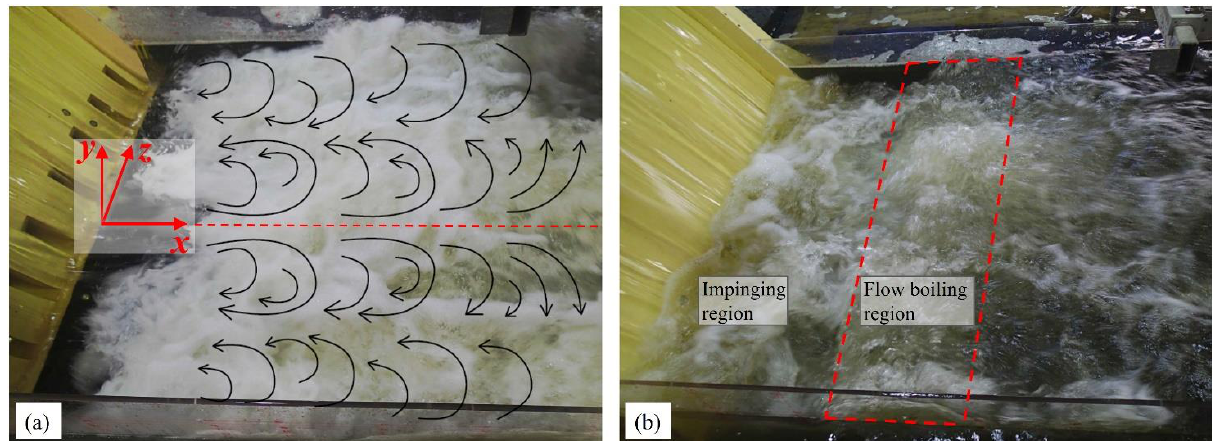
Figure 1. Flow pattern of hydraulic jumps in a stilling basin with discharge per unit width q = 0.19 m 2 /s, Froude number upstream of the jump toe Fr 1 = 6.7, and Reynolds number Re = 1.9 × 10 5 : ( a ) stilling basin without super-cavitating blocks; ( b ) stilling basin with super-cavitating blocks.